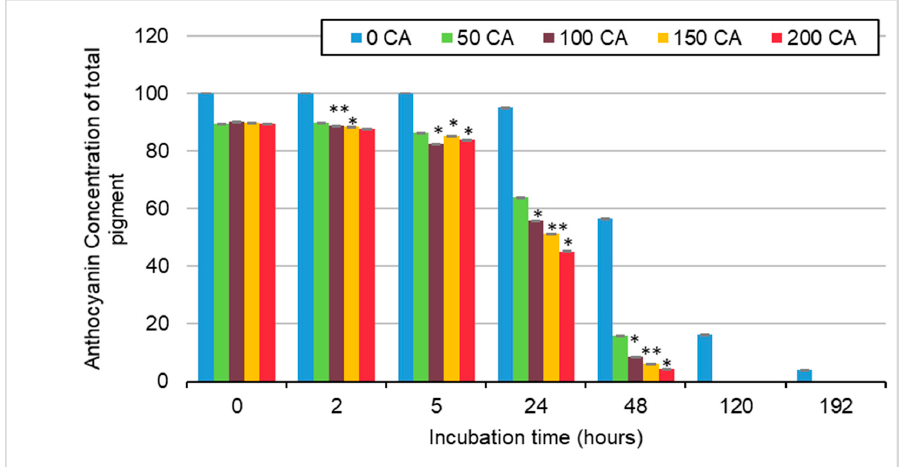
Figure 6. Average total pyranoanthocyanin (PACN) as part of total pigment after time in incubation at 65 °C with samples containing anthocyanin to caffeic acid molar ratios of 1:0, 1:50, 1:100, 1:150, and 1:200. Error bars represent the standard deviations. Significant difference from anthocyanin to caffeic acid molar ratio of 1:50 for the same incubation time with * p < 0.05.